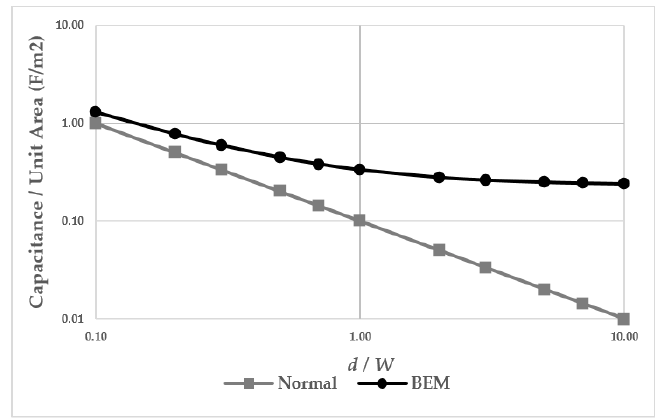
Figure 4. Capacitance value: Ideal parallel-plate calculation vs. BEM. Table 1. Estimated self-capacitance of the sensor array based on the ideal parallel-plate equation and BEM.